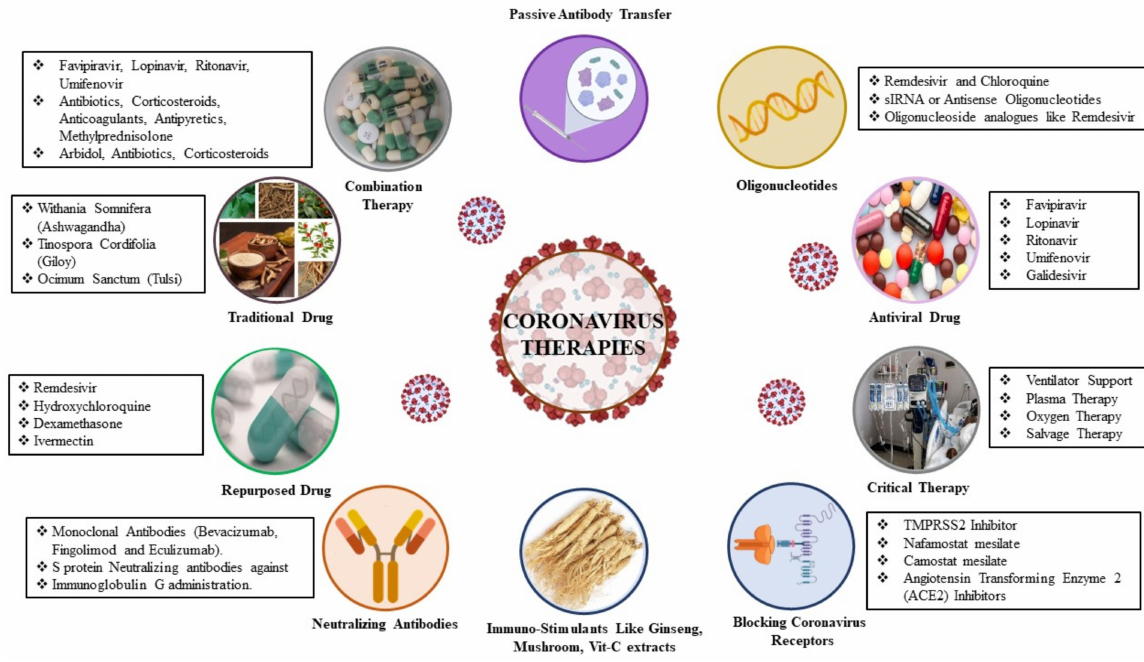
Figure 5. Therapeutic approaches to SARS-CoV-2